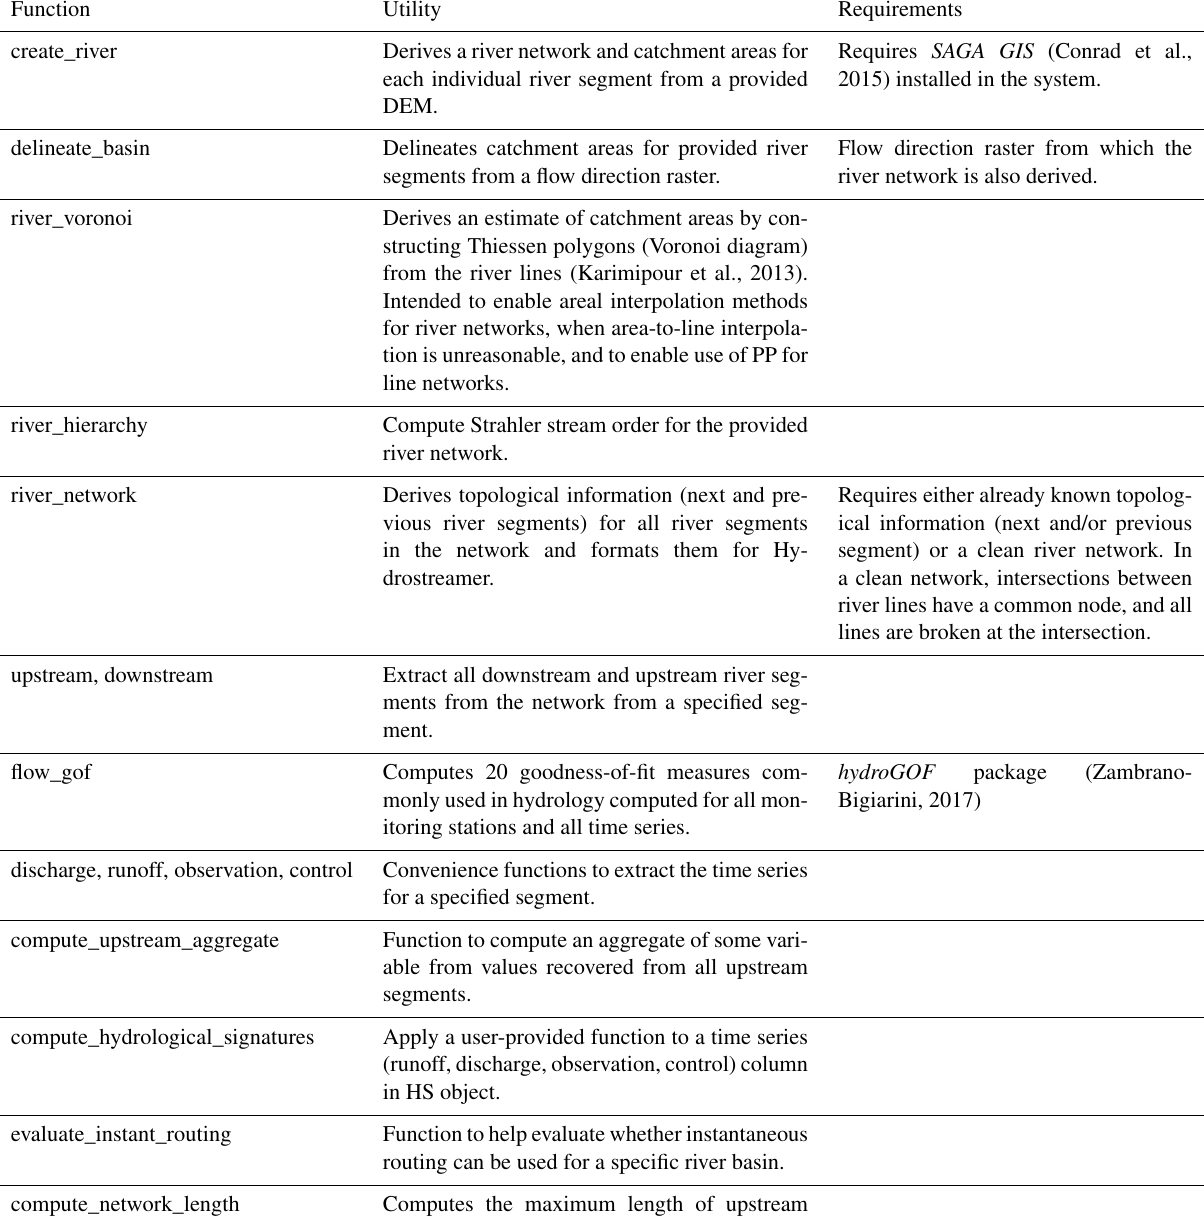
Table 2. Auxiliary functions in Hydrostreamer v1.0, their intended utility, and their data and software requirements. Function